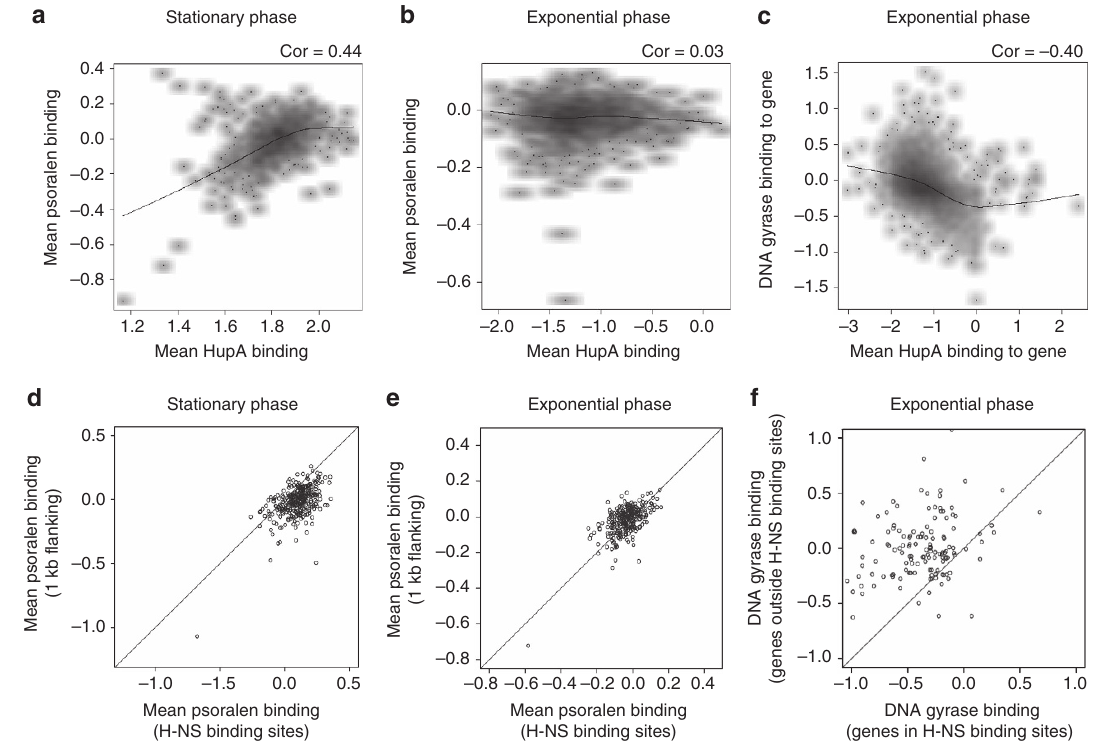
Figure 3 | Nucleoid-associated proteins are associated with supercoiling. ( a ) Smoothed scatter plot of average psoralen binding versus average HupA binding in 5Kb bins covering the entire E. coli genome, during stationary phase. Black line represents loess fit. ( b ) Smoothed scatter plot of average psoralen binding versus average HupA binding in 5Kb bins covering the entire E. coli genome, during exponential phase. Black line represents loess fit. ( c ) Smoothed scatter plot of DNA gyrase binding versus average HupA binding to genes in exponential phase. Black line represents loess fit. ( d ) Scatter plot of average psoralen binding in H-NS binding sites versus average psoralen binding in the 1Kb regions flanking them, during stationary phase (Paired Wilcoxon test P o 10 (cid:2) 15 ). Black line has slope ¼ 1. ( e ) Scatter plot of average psoralen binding in H-NS binding sites versus average psoralen binding in the 1Kb regions flanking them, during exponential phase. Black line has slope ¼ 1. ( f ) Scatter plot of DNA gyrase binding in 135 pairs of genes less than 1Kb apart, where one gene is within an H-NS binding site and the other is outside. Black line has slope ¼